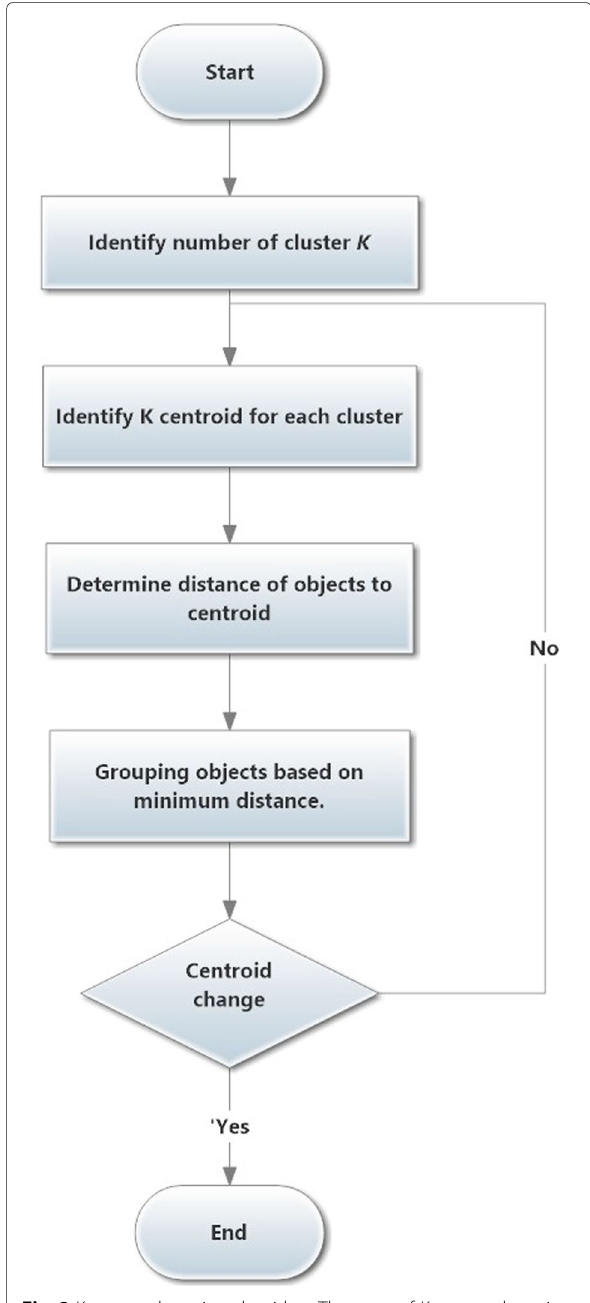
Fig. 2 K -means clustering algorithm. The steps of K -means clustering algorithm are outlined